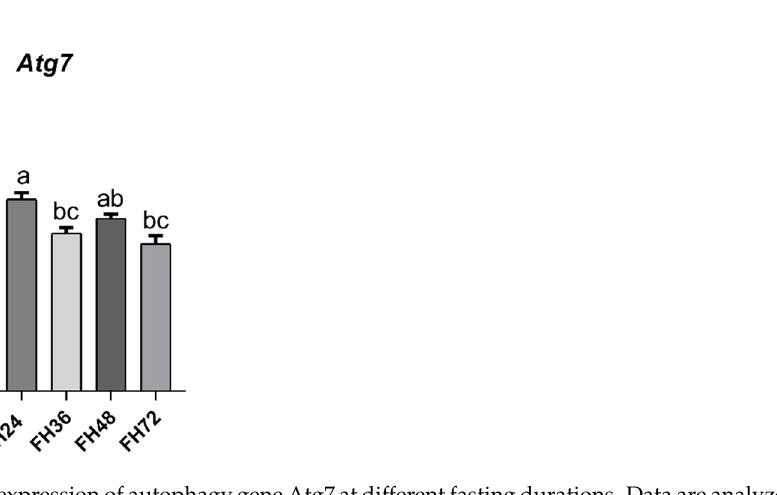
Figure 2. Relative expression of autophagy gene Atg7 at different fasting durations. Data are analyzed by ANOVA and multiple comparisons using the Duncan correction. Values are means ± SEM, n = 8. Labeled means without a common letter are significantly different, p ≤ 0.05. CT—birds fed ad libitum; FH12—birds fasted for 12 h; FH24—birds fasted for 24 h; FH36—birds fasted for 36 h; FH48—birds fasted for 48 h.